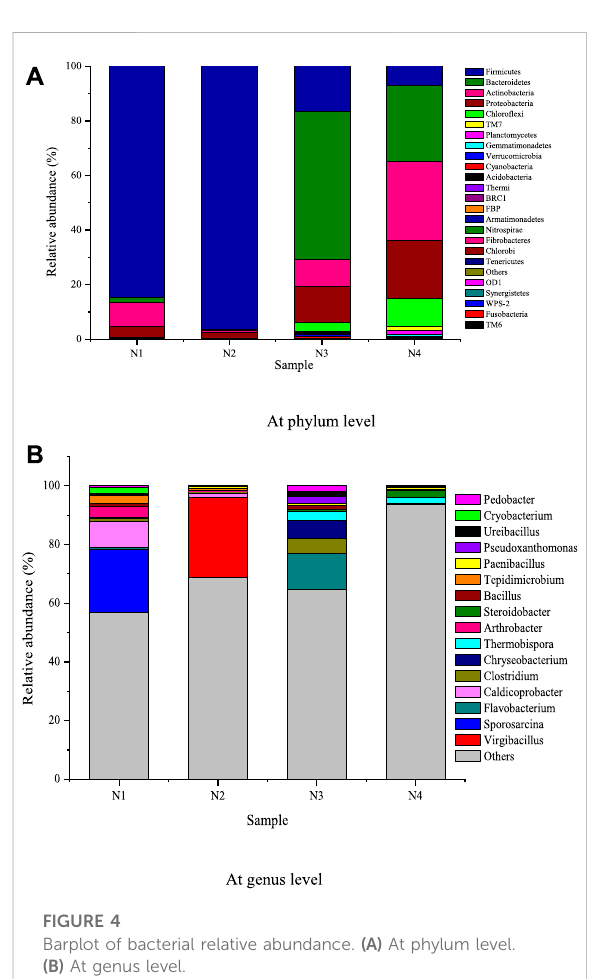
FIGURE 4 Barplot of bacterial relative abundance. (A) At phylum level. (B) At genus